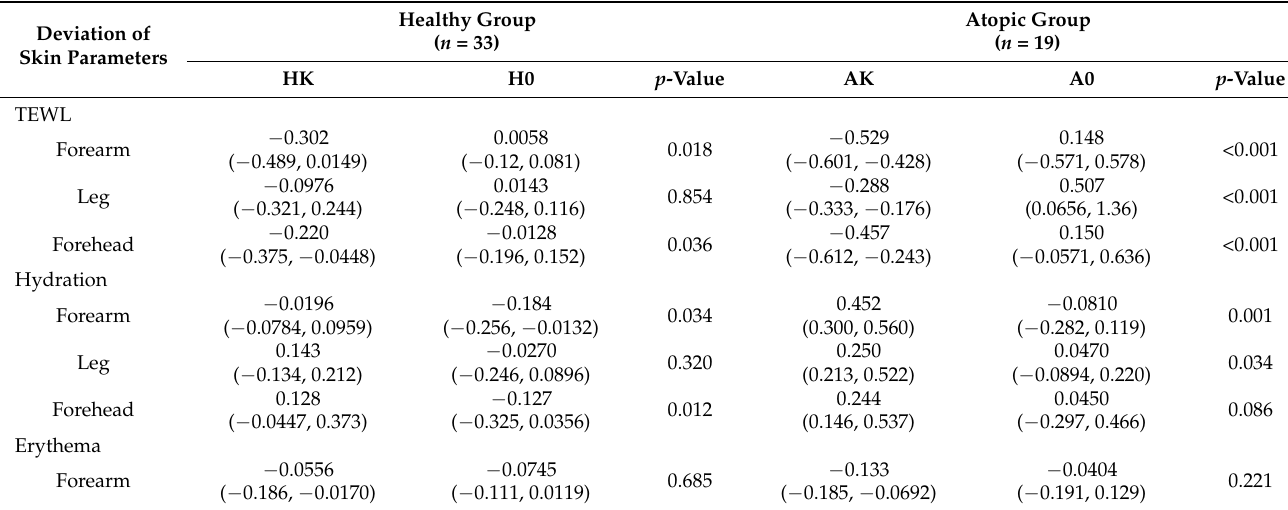
Table 3. Comparison of skin parameters variation, between kefir intake and control groups, for both healthy and atopic volunteers, after eight weeks of kefir ingestion (median (Q1,